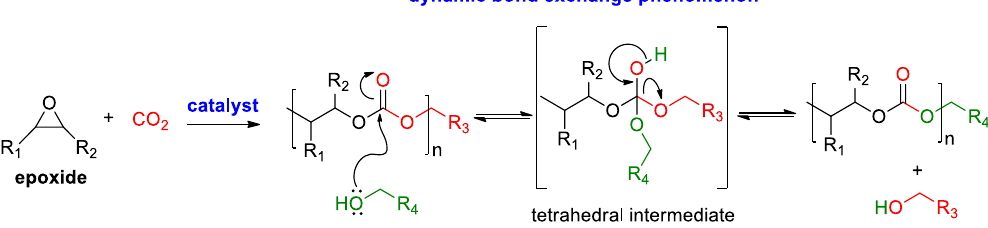
Scheme 2. The synthetic route toward polycarbonates via ring-opening polymerization (ROP), and depiction of the dynamic bond exchange phenomenon. Reproduced from ref. [47] with permission from the American Chemical